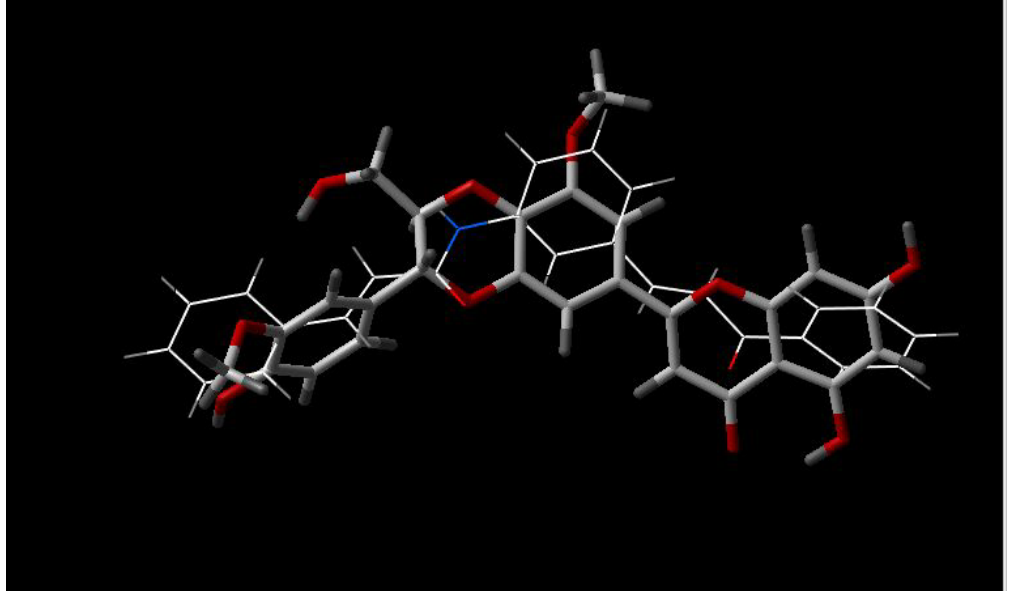
Figure 1. Best fit of optimized 5'-methoxyhydnocarpin (sticks) and INF 240 (wireframe)